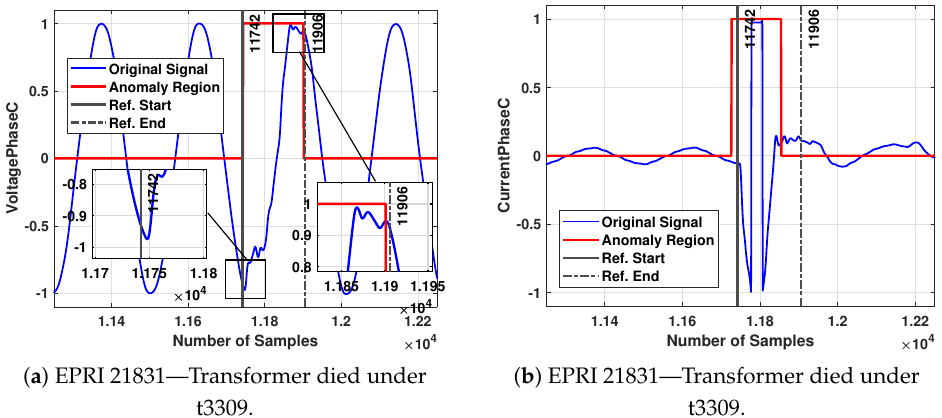
Figure 3. Detection performance of the proposed energy detector approach for DOE/EPRI National Disturbance Library [20]. Red lines show the output of the algorithm, and blue lines represent the original captured waveform. Black lines show the reference anomaly start sample and end sample,